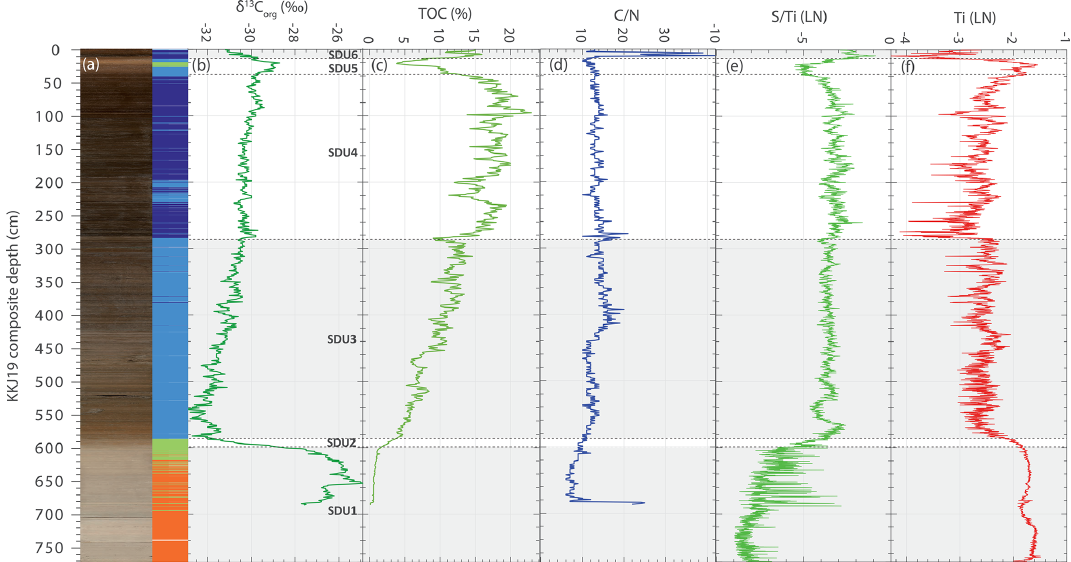
Figure 4. Composite profile KKJ19 with selected proxy records. (a) Photograph of composite profile KKJ19 with XRF-based element cluster stratigraphy and corresponding (b) δ 13 C org , (c) total organic carbon (TOC), (d) C / N, (e) S / Ti and (f) Ti records. Sediment deposition units (SDUs) 1 to 6 are